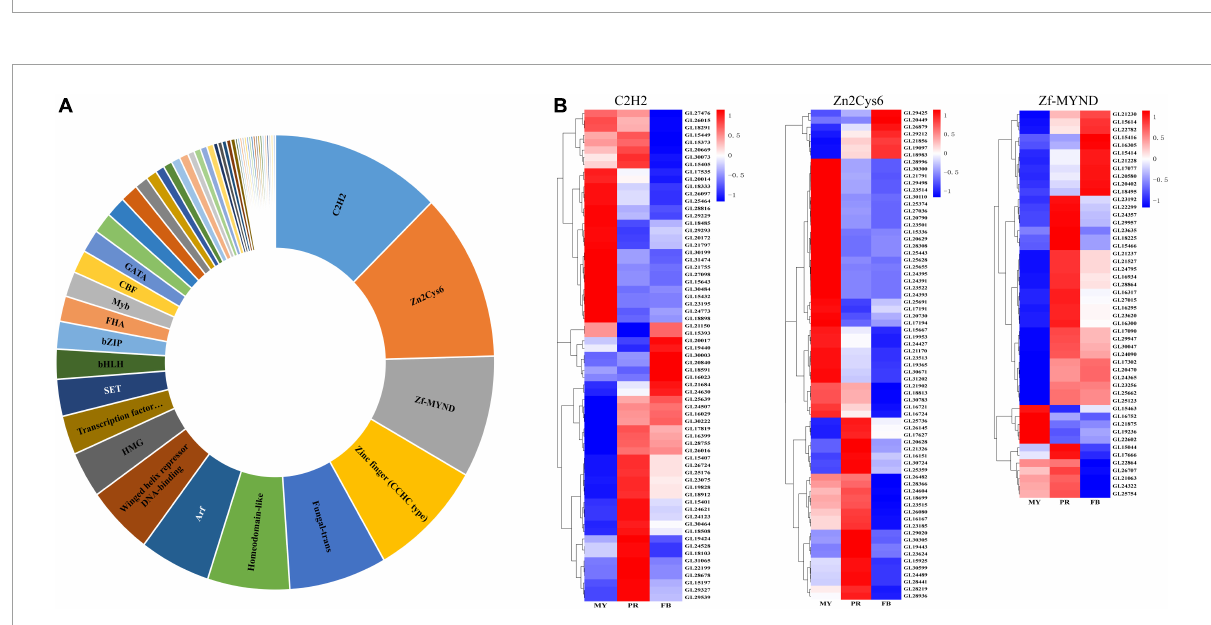
FIGURE4 The transcription factors in Ganoderma lucidum. Panel (A) is the transcription factors family in G. lucidum . Panel (B) is the expression levels of C2H2, Zn2Cys6, and Zf-MYND in the development of G. lucidum . MY, mycelia; PR, primordia; FB, fruiting